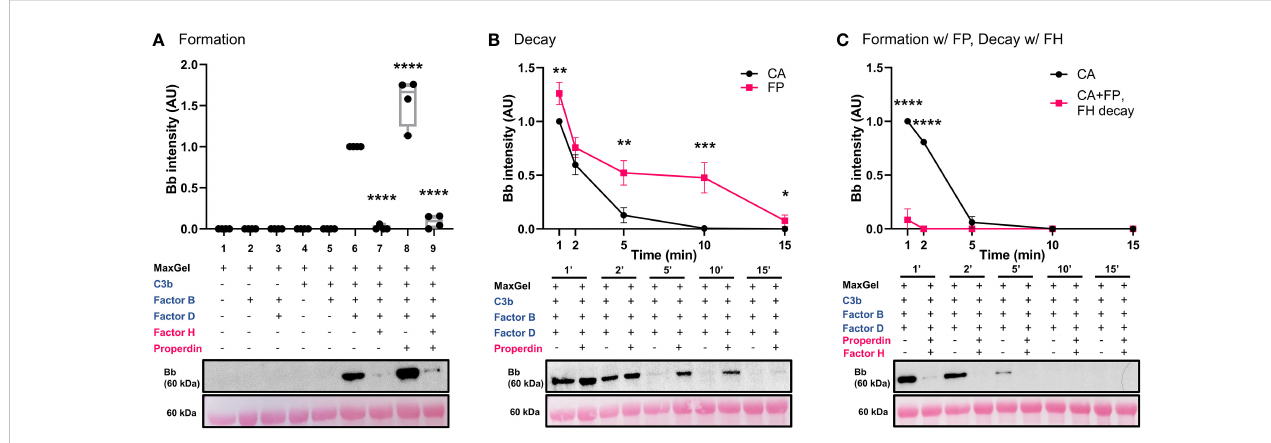
FIGURE 3 C3 convertase assembles, decays on ECM surface and is regulated by RCA proteins. (A) Western blot analysis of C3 convertase formation on ECM surface. MaxGel does not contain complement proteins necessary to form C3 convertase (lanes 1-5). C3 convertase alone (CA) forms in presence of C3b, FB and FD (lane 6), and is regulated by inhibitory FH (lane 7), stabilizing FP (lane 8) or a mix of FH+FP (lane 9). Results were normalized to CA and presented as relative protein expression. Box plots show median, 1 st and 3 rd quartile ranges, and the individual data points of four independent experiments. Signi fi cance calculated for CA. (B) Western blot analysis of timed decay (1-15 min) of CA formed alone or in presence of Properdin. FP increases C3bBb half-life more than 2-fold (CA t 1/2 = 3.1min; FP t 1/2 = 7.4min). (C) Western blot analysis of timed decay (1-15 min) of CA formed alone or in presence of properdin (C3bBb(P)), followed by FH-mediated decay of C3bBb(P). FH increases decay of C3bBb(P) (CA t 1/2 = 3.2min; C3bBb(P)+FH t 1/ 2 <1min). Results were normalized to CA at 1 min and presented as relative protein expression. Ponceau S Staining was used as a measure of total protein load. Mean±SD of four independent experiments. Signi fi cance calculated for CA at respective timepoints. * P ≤ 0.05, ** P ≤ 0.01, *** P ≤ 0.001, **** P ≤